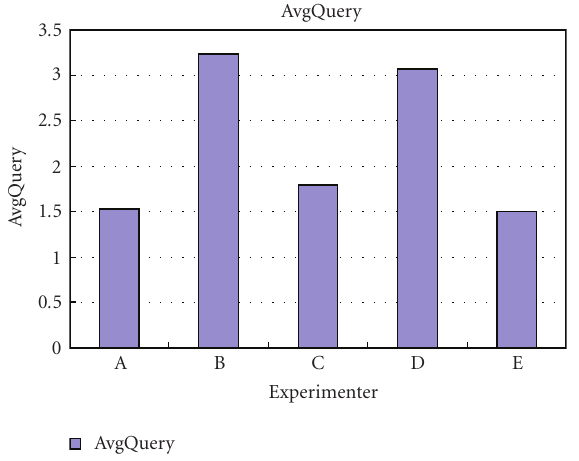
Figure 8: AvgQuery of five